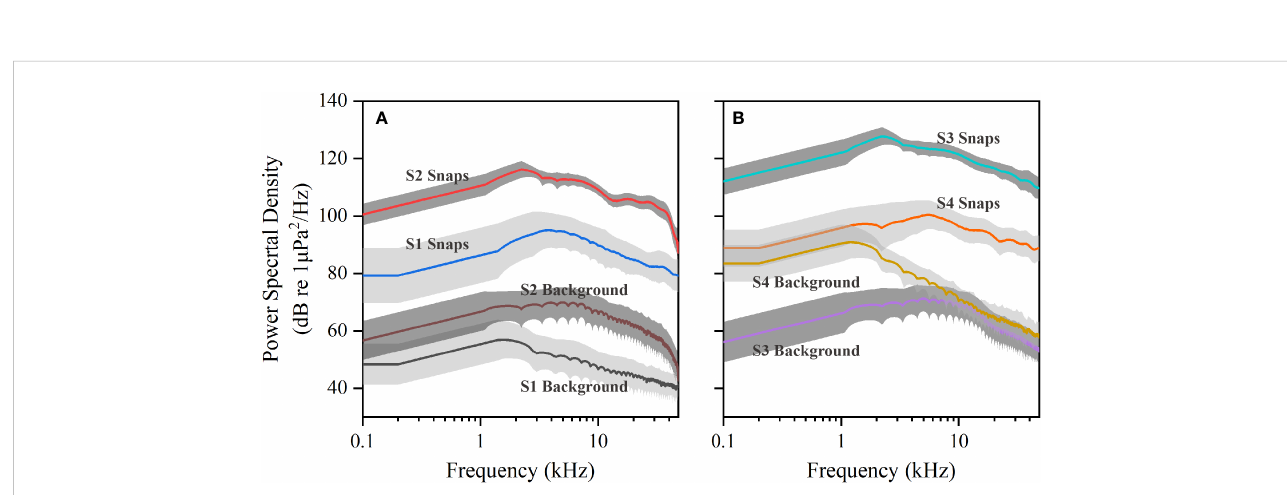
FIGURE 3 The comparison between the mean and SD (gray shading) frequency spectra of snaps and local background noise in decibels for (A) Site 1 and Site 2 and (B) Site 3 and Site 4.